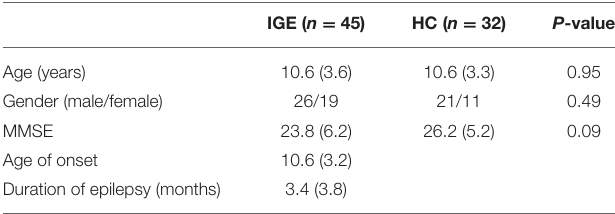
TABLE 1 | Demographic and clinical information on epilepsy patients and healthy controls.